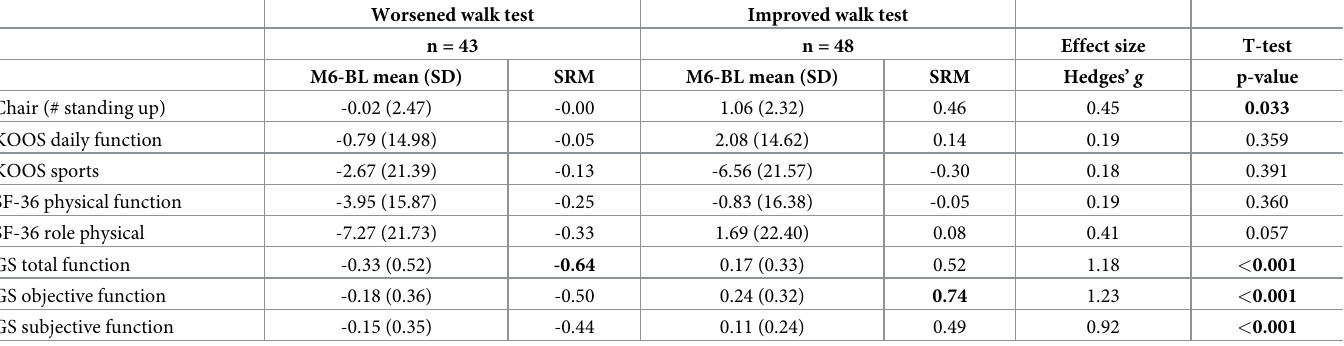
Table 6. Standardized response means and effect sizes of different functional outcome measures in subgroups based on MDC (= 0.19m/s) of the 40m self paced walk